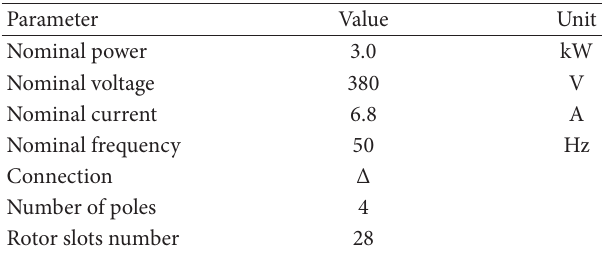
Table 2: Induction motor technical